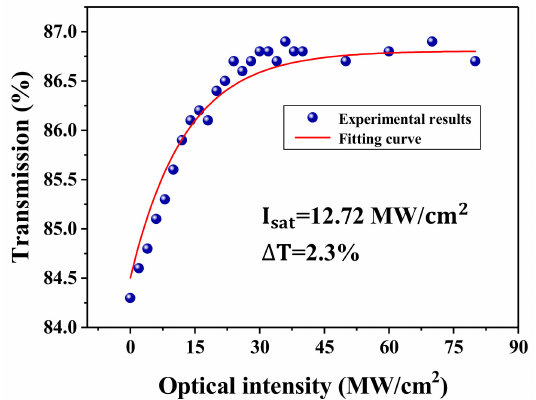
Figure 3. The nonlinear absorption characteristics of the ZrSe 2 –PVA